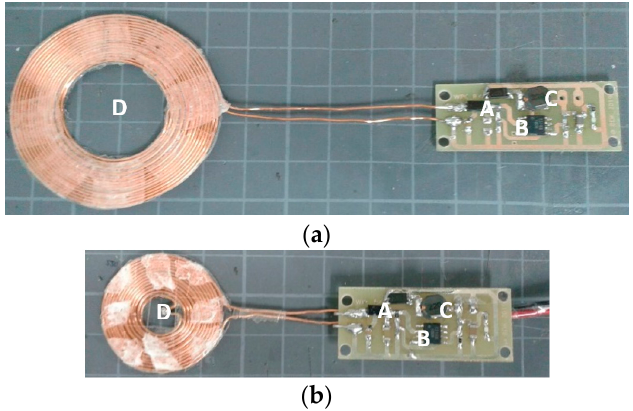
Figure 13. The wireless power receiver apparatus core. Part A is a voltage rectifier and input filter, part B is a voltage regulator, part C is an output filter and protection, and part D is receiver coil.